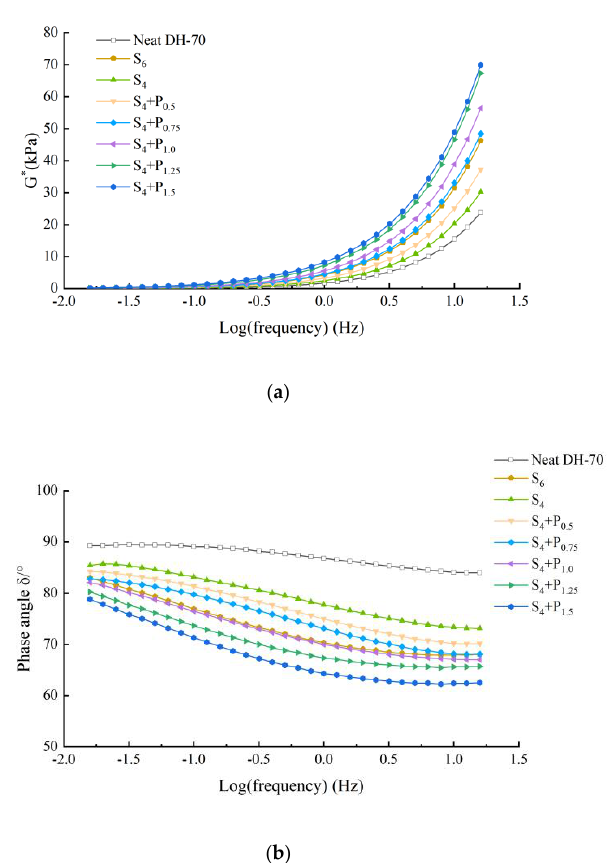
Figure 5. Complex modulus and phase angle of compound PPA–SBS modified binders of DH–70# asphalt: ( a ) Complex modulus-Log(frequency) results; ( b ) Phase angle-Log(frequency) results.